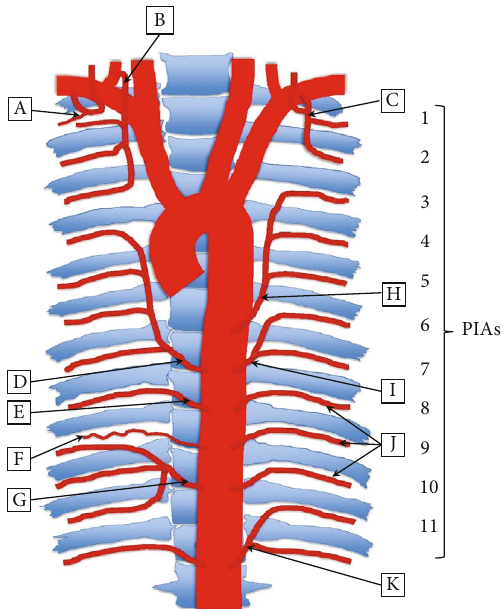
Figure 2: Graphic representation of variations of arterial branching pattern of the posterior thoracic wall, as seen in an 81-year-old cadaver: (a) right highest intercostal artery, supplying only 1st ICS; (b) right descending branch of vertebral artery, supplying 1st-3rd ICS; (c) left highest intercostal artery, following typical anatomical arterial supply; (d) right superior common trunk, giving o ff 4th-7th PIAs; (e) right 8th PIA, directly from the TA; (f) right 9th PIA, with diminished size directly from TA; (g) right inferior common trunk, giving of 9th-11th PIAs; (h) left superior common trunk, giving o ff 3rd-5th PIAs; (i) left middle common trunk, giving o ff 6th-7th PIAs; (j) left 8th, 9th, and 10th PIAs, directly from the TA; (k) left inferior common trunk, giving o ff 11th PIA and subcostal